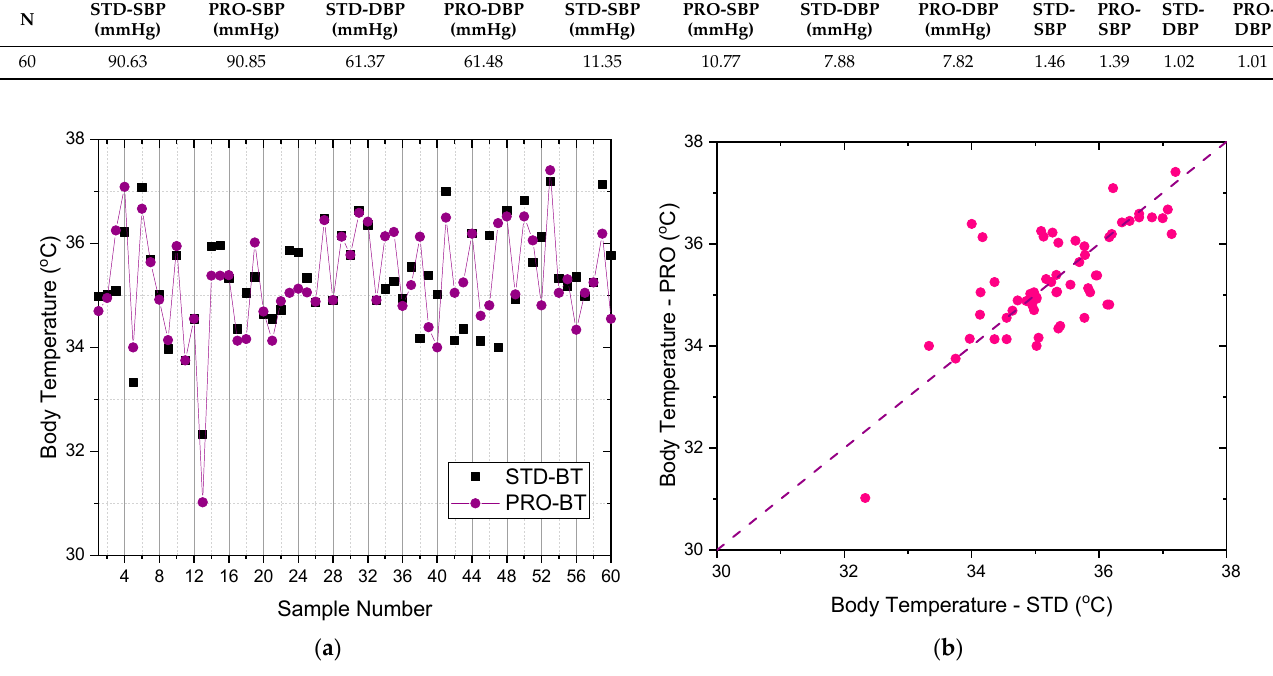
medical equipment of OMRON infrared thermometer (STD): ( a ) the overlay plot; ( b ) the comparison plot.